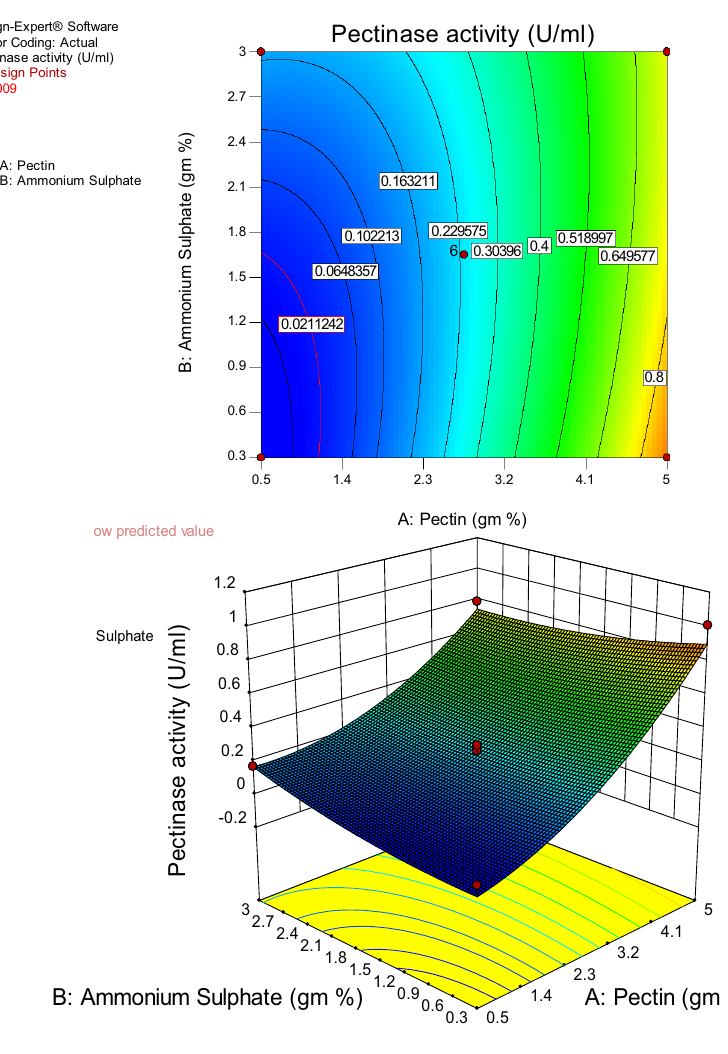
Figure 10. Contour plot ( A ) and response surface plot ( B ) of the interactive effect of ammonium sulphate and pectin on the Pectate lyase production by Paenibacillus lactis PKC5.